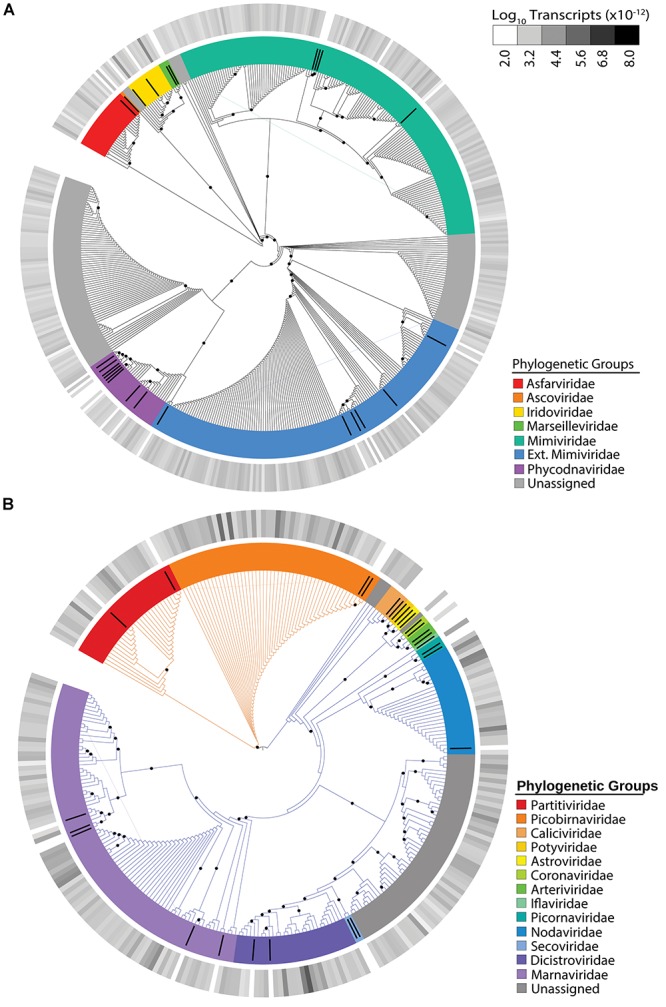
Maximum-likelihood phylogenetic placement of NCLDV candidates (A) and RNA virus candidates (B). Reference proteins are denoted by black bars with colors indicating viral family (Supplementary Table 2). Orange branches indicate dsRNA viruses and blue branches indicate ssRNA viruses (B). The outer heatmap ring indicates normalized transcript abundance for each candidate summed for all samples. Black dots represent bootstrap values >0.5.